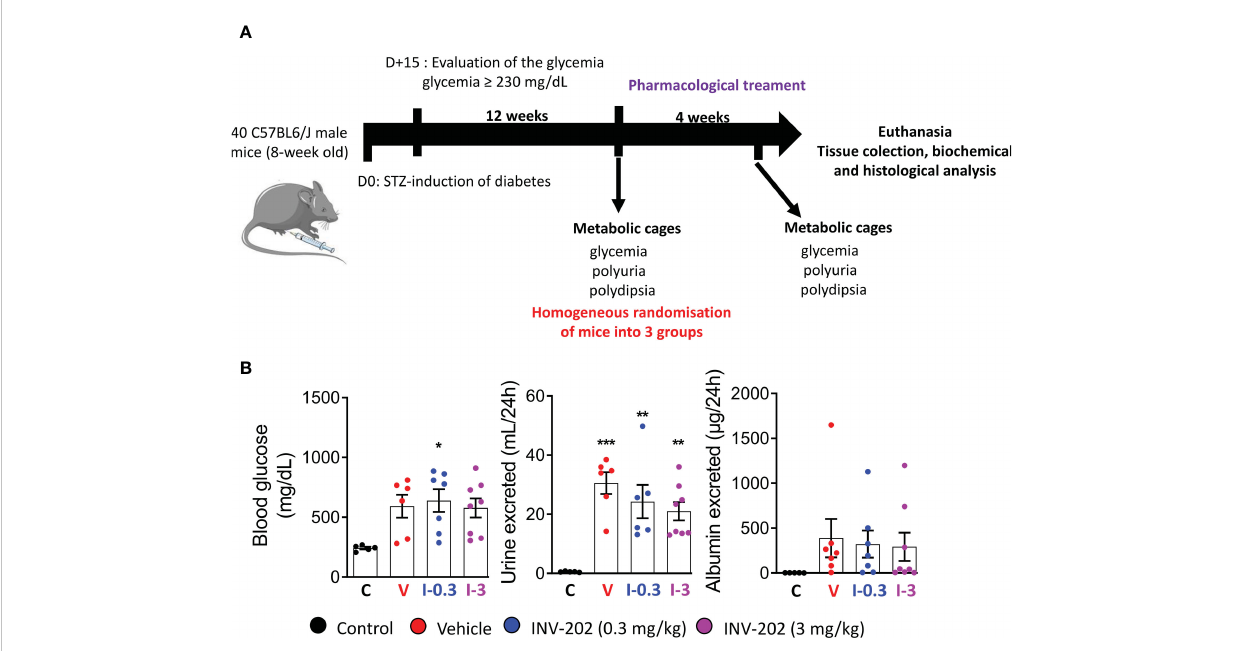
FIGURE 1 Induction of diabetes and randomization of diabetic mice. (A) Schematic of in vivo approach. (B) Randomization of mice with comparable glycemia, polyuria, and albuminuria into 3 groups: Control (n = 5), Vehicle (n = 6), INV-202 (0.3 mg/kg; n = 7), INV-202 (3 mg/kg; n = 8).Statistical signi fi cance versus nondiabetic controls: *p < 0.05; **p < 0.01; ***p < 0.001. STZ, streptozotocin. C: non-diabetic control mice, V: Vehicle-treated diabetic mice, I-0.3: INV-202-treated diabetic mice (0.3 mg/kg), I-3: INV-202-treated diabetic mice (3